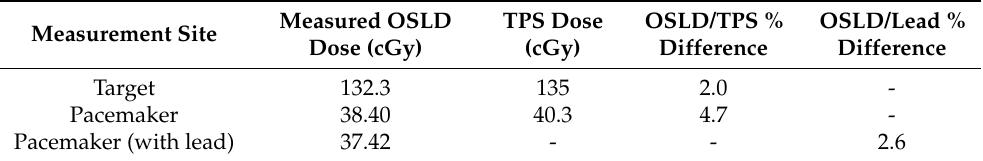
Figure 14. Optical annealing results. ( a ) Reduction of OSLD signal with 2080 min of illumination exposure; ( b ) Reduction in OSLD signal from 60 min to 2080 min of illumination exposure. Table 4. Freiburg flap measurements. This table displays the results of the Freiburg flap applicator end-to-end test.